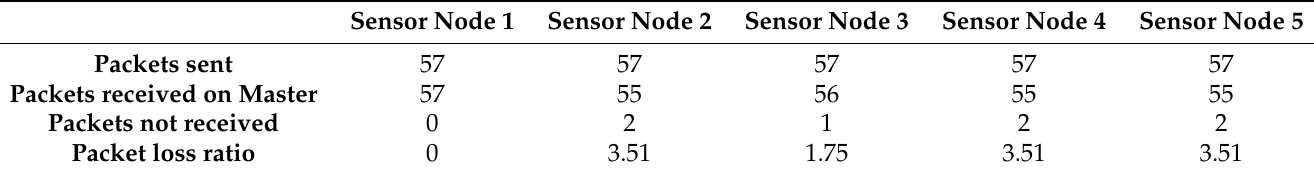
Table 8. LoRa Radio Communication Static Test 1. Communication in line of sight.